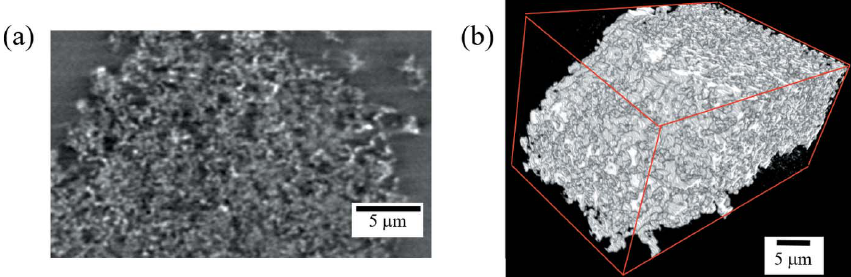
Figure 4 Nano-CT images of a cut MPL piece in dark phase-contrast mode. ( a ) Reconstructed CTimage, and ( b ) 3D rendered